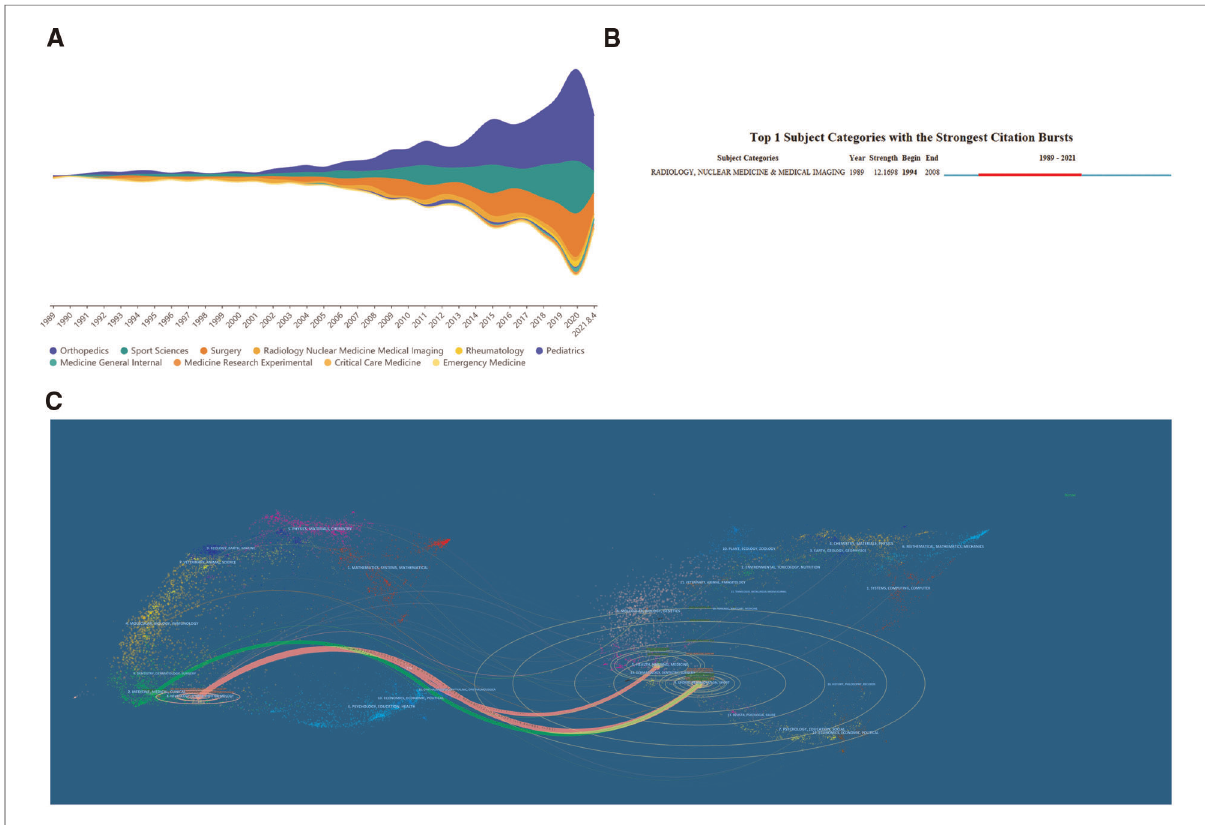
FIGURE 5 The discipline wise contribution of meniscal root tears research. ( A ) Steam graph of the top 10 research areas. ( B ) The strongest citation bursts of research categories. ( C ) The dual-map overlay of journals related to meniscal root tears